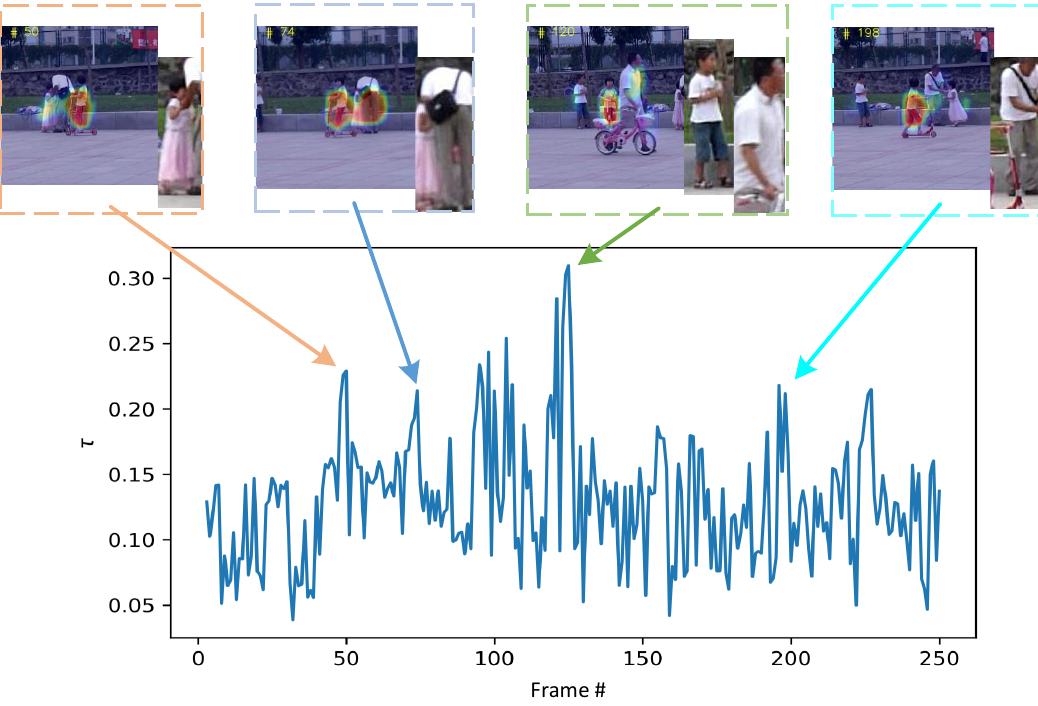
Figure 4. The plot of τ values on Girl2 of the OTB dataset ( bottom row), the heated score map of potential occlusion scenes, and corresponding negative templates ( top row). In the τ plot, the peaks indicate potential occlusions, leading to an unreliable tracking